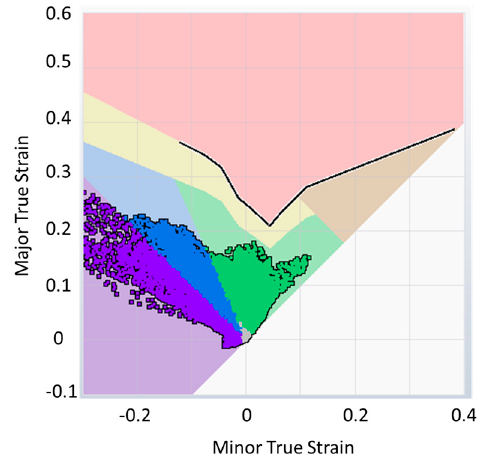
Figure 6. Formability limit diagram (FLD).